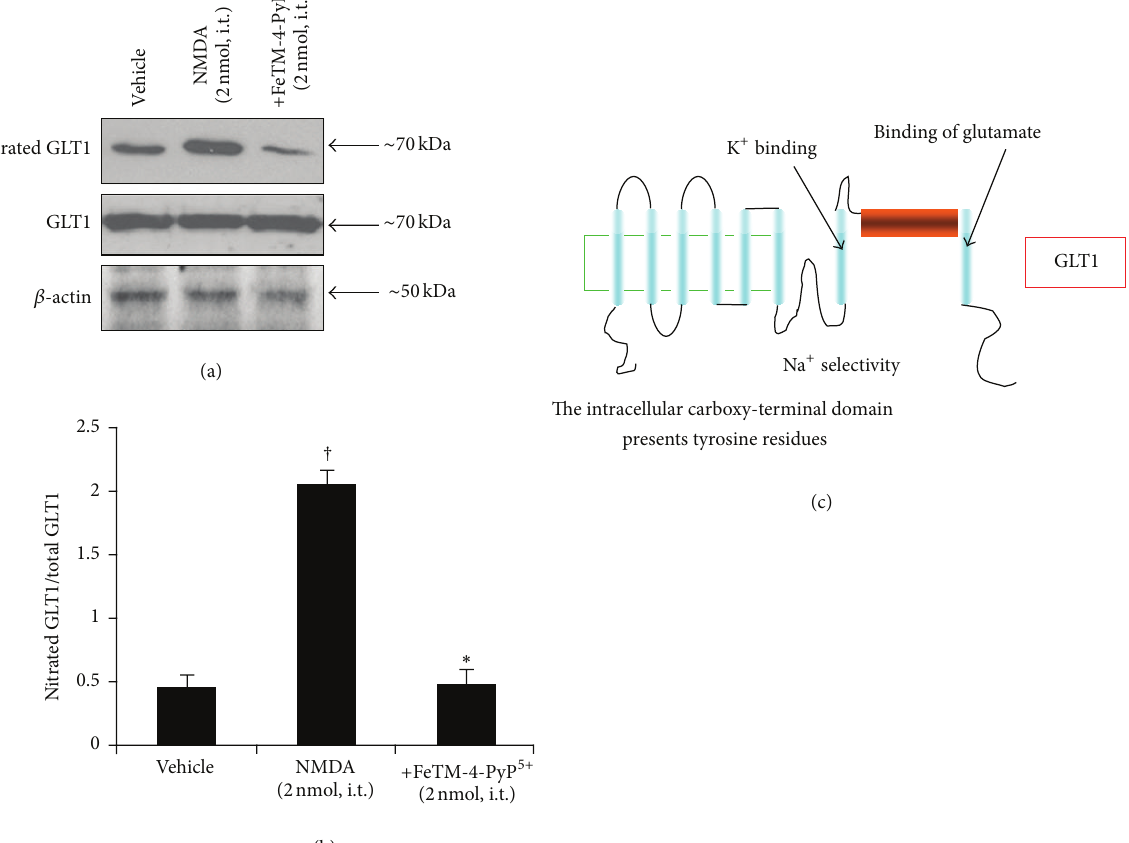
Figure 4: NMDA (2nmol) induced thermal hyperalgesia was also associated with nitration of the glutamate transporter GLT1 ((a)–(c)). At the time at which hyperalgesia was at its peak (40 minutes), immunoprecipitation analysis revealed that FeTM-4-PyP 5+ (2nmol given 15min before NMDA) reduced the NMDA mediated nitration of GLT1 at the level of the spinal cord ((a), (b)). Immunoprecipitation data are representative of at least 6 gels from 3 different animals performed on different days. Bar graph in (b) represents quantification by densitometric analysis. No difference for GLT-1 or 𝛽 -actin expression was detected among the lanes in these conditions. † 𝑃 < 0.001 compared to vehicle and ∗ 𝑃 < 0.001 compared to NMDA